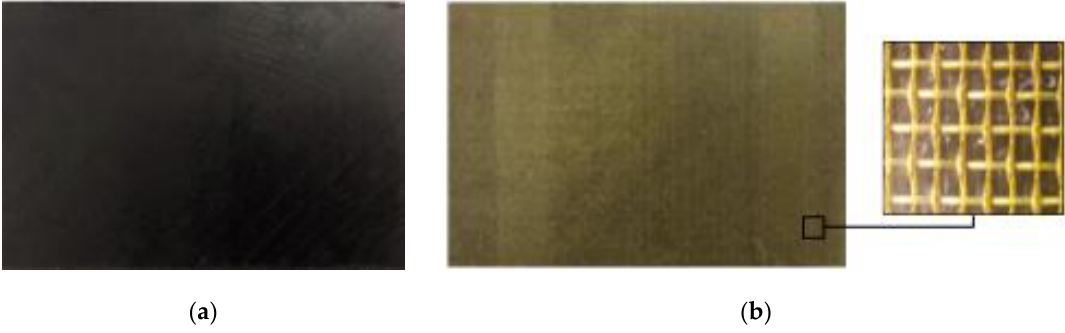
Figure 1. Appearance of specimens. ( a ) The unprotected carbon fiber reinforced polymer (CFRP) laminates (Group A); ( b ) the copper mesh protected CFRP laminates (Group B).